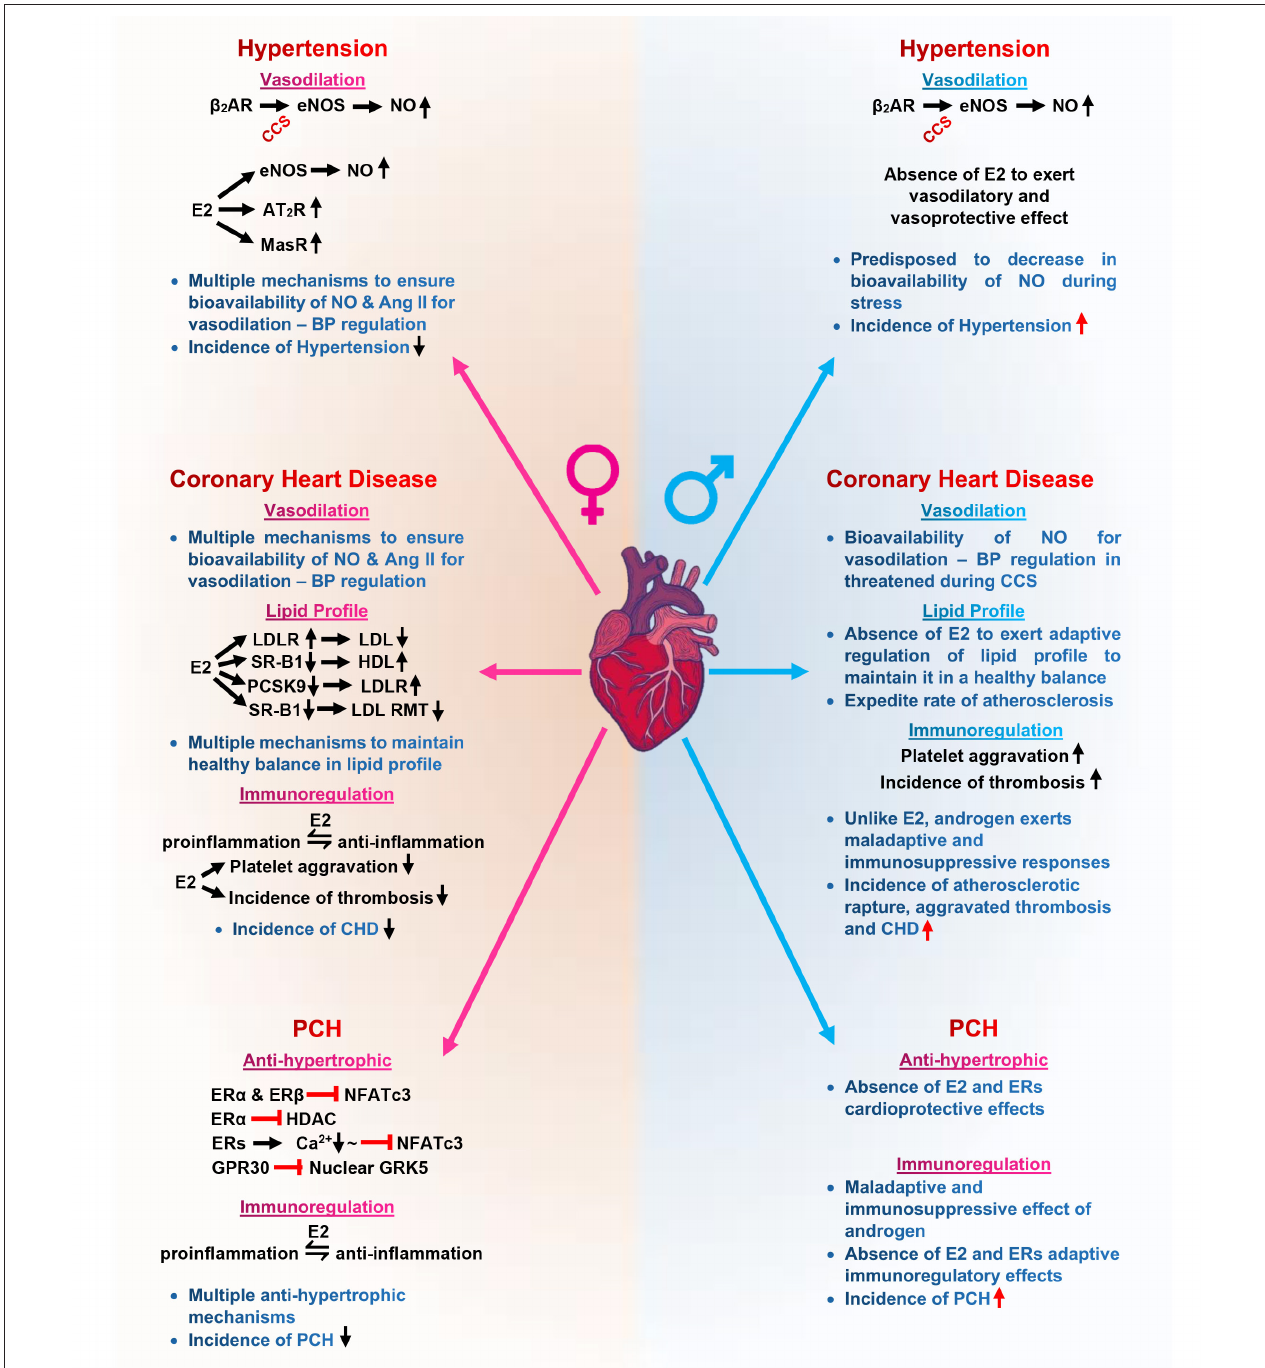
FIGURE 2 | Graphical abstract of sex–gender disparities in cardiovascular diseases mediated by the mechanistic role of estrogen on eNOS, lipid profile, and NFATs. eNOS, endothelial nitric oxide synthase; NO, nitric oxide; Ang II, angiotensin II; AT2R, angiotensin II receptor type 2; MasR, Mas receptor; LDL, low-density lipoprotein; LDLR, low-density lipoprotein receptor; RMT, receptor-mediated transcytosis; SR-B1, scavenger receptor class B type 1; PCSK9, proprotein convertase subtilisin/kexin type 9; GRK5, G protein-coupled receptor kinases 5; HDAC, histone deacetylase; , signaling; , upregulate; , downregulate; , inhibit; , normalize.